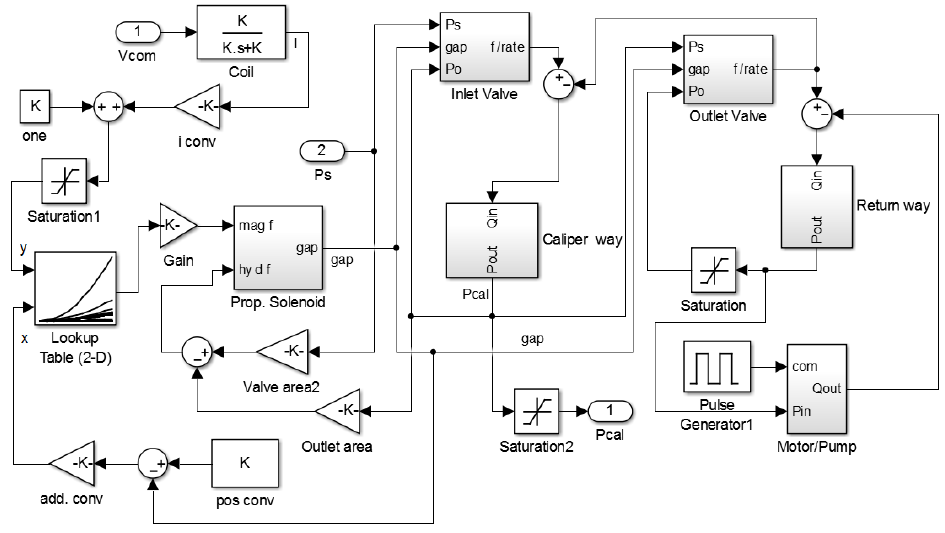
Figure 13. Block diagram of single-wheel PEHB system.